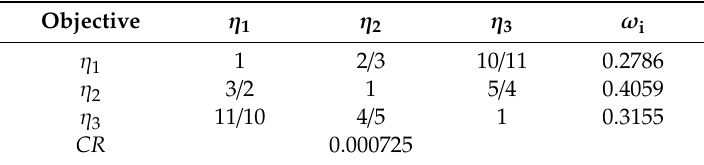
Table 4. Evaluation results and weight factors. CR , consistency ratio.